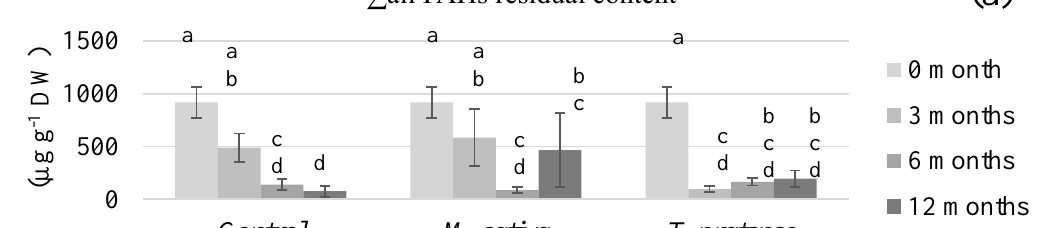
the same letter are not significantly different ( p > 0.05).